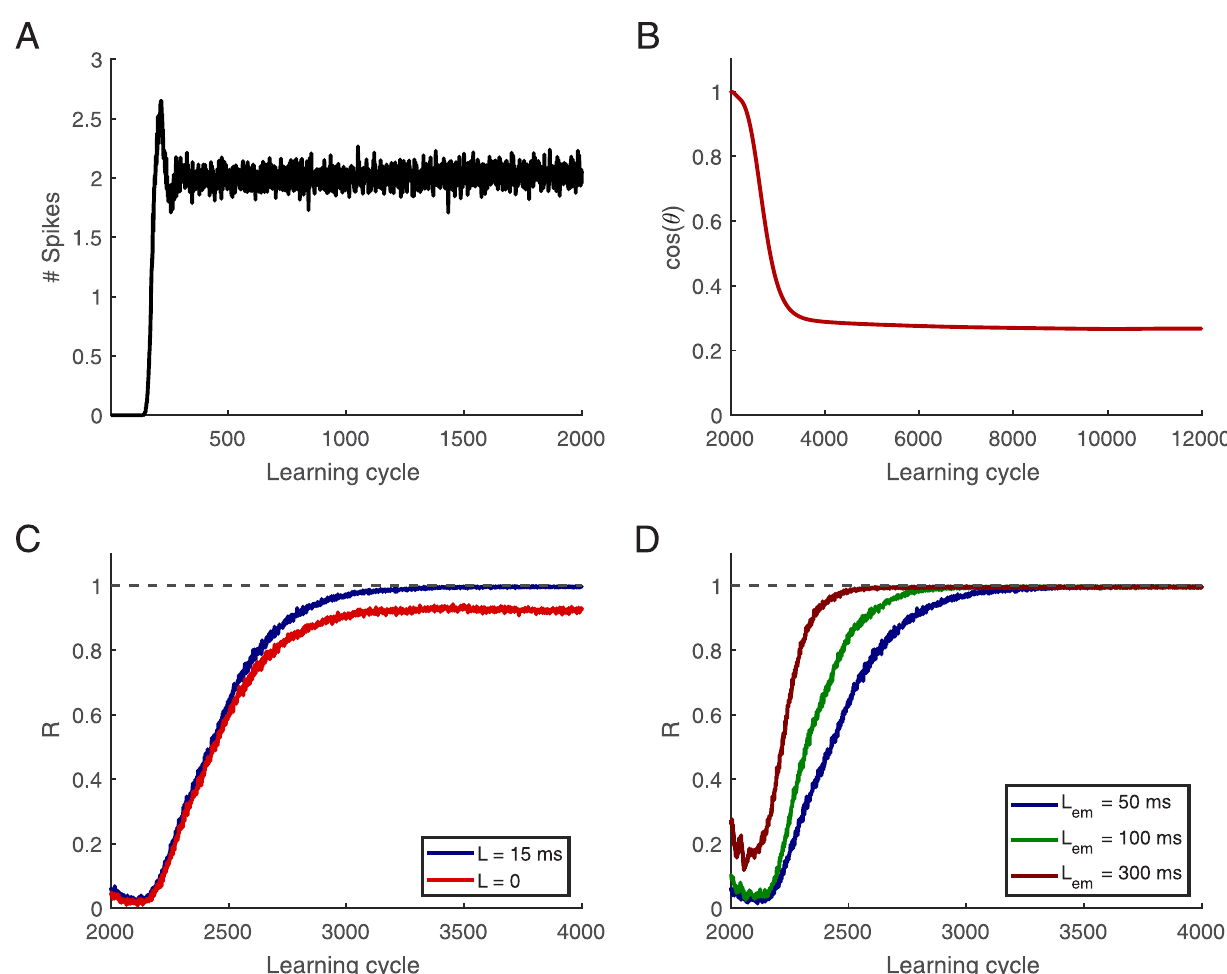
Fig 3. Convergence of learning. There is no embedded pattern till learning cycle 2000 in afferents, and there is a 50 ms embedded pattern in afferent from learning cycle 2001 shown in afferents beginning from 500 ms. (A) Number of elicited spikes versus learning cycle, on average the post-synaptic neuron fires two times in response to the noisy background. (B) The cosine between the current weight vector and the initial weight vector at learning cycle 2000. (C) Learning performance R versus learning cycle, for L = 0 and L = 15 ms. A 50 ms pattern is embedded between 500 and 550 ms. (D) R versus learning cycle, L = 15 ms. Patterns duration, L em , are 50, 100, and 300 ms, shown in afferents from 500 ms. R is an average of 500 simulations, in which there are 500 afferents, and the length of the training epoch is 1000 ms. The desired firing rate is r 0 = 2